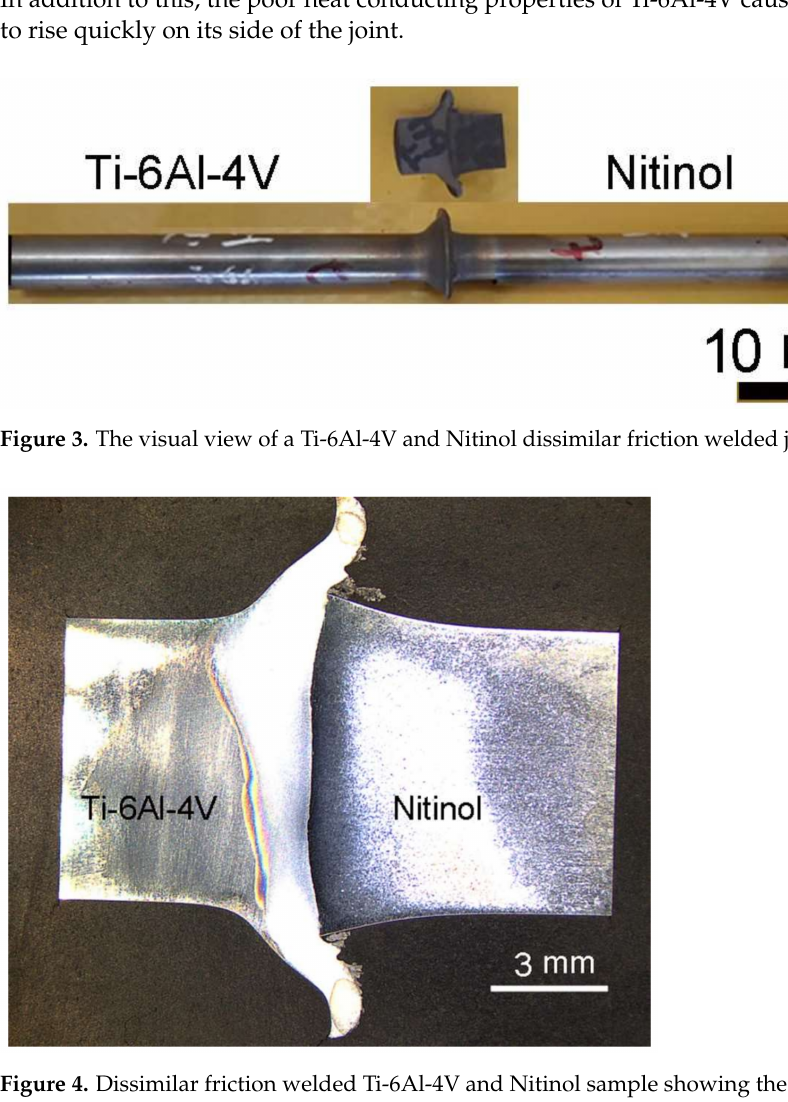
Figure 4. Dissimilar friction welded Ti-6Al-4V and Nitinol sample showing the flash on the Ti-6Al- 4V